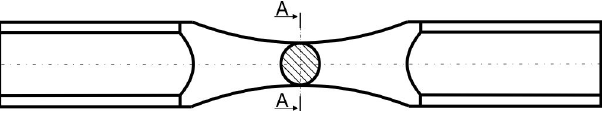
Figure 4. Cross section of fatigue samples used in fractographic observations.